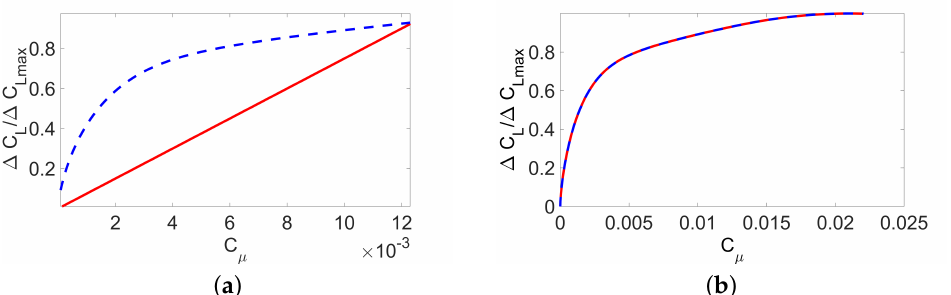
Figure 6. The static map comparison between experimental data (dashed blue line) and model (red line). ( a ) Linear time invariant (LTI) model; ( b ) Wiener model. ∆ C L is the lift variation relative to the non-actuated lift, and ∆ C Lmax is defined as the maximum achievable ∆ C L corresponding to the maximum actuation